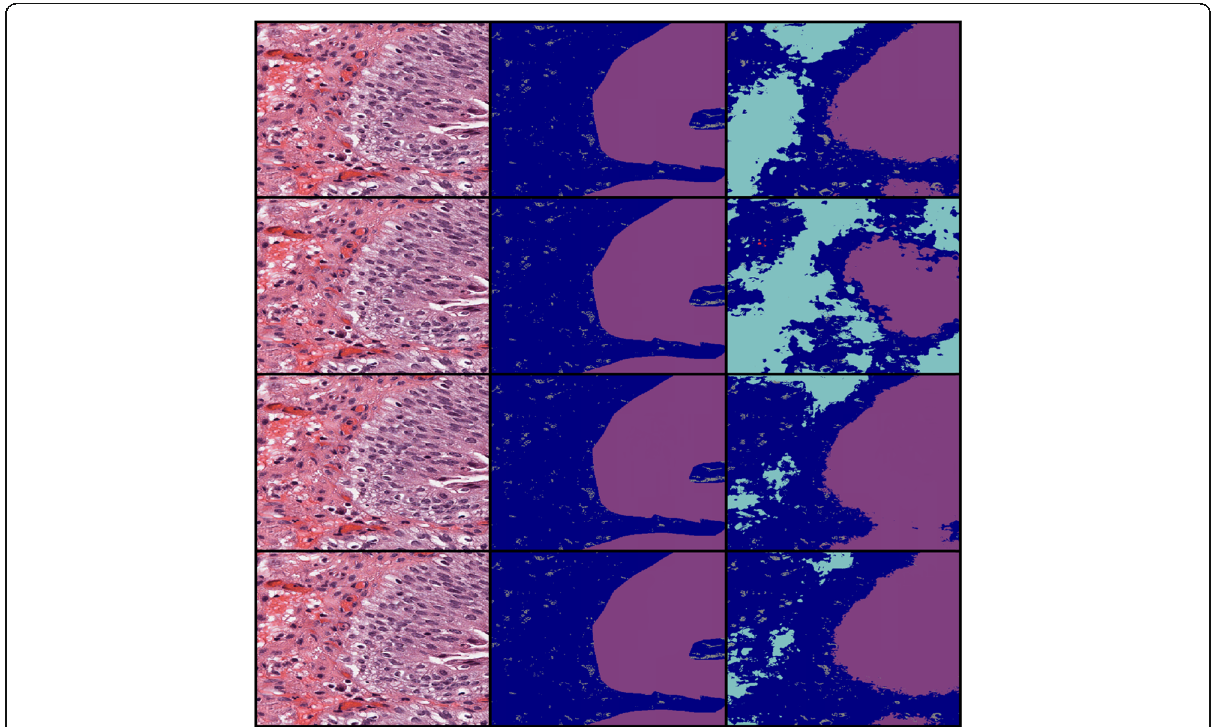
Fig. 4 Prediction Results. Leftmost column is the input image, middle column is the ground truth, and rightmost is the prediction. The rows in descending order are: Glorot Normal, Glorot Uniform, He Normal, and He Uniform . The color purple is mucosa, light blue is lamina propria, dark blue is unlabeled, and gray is background